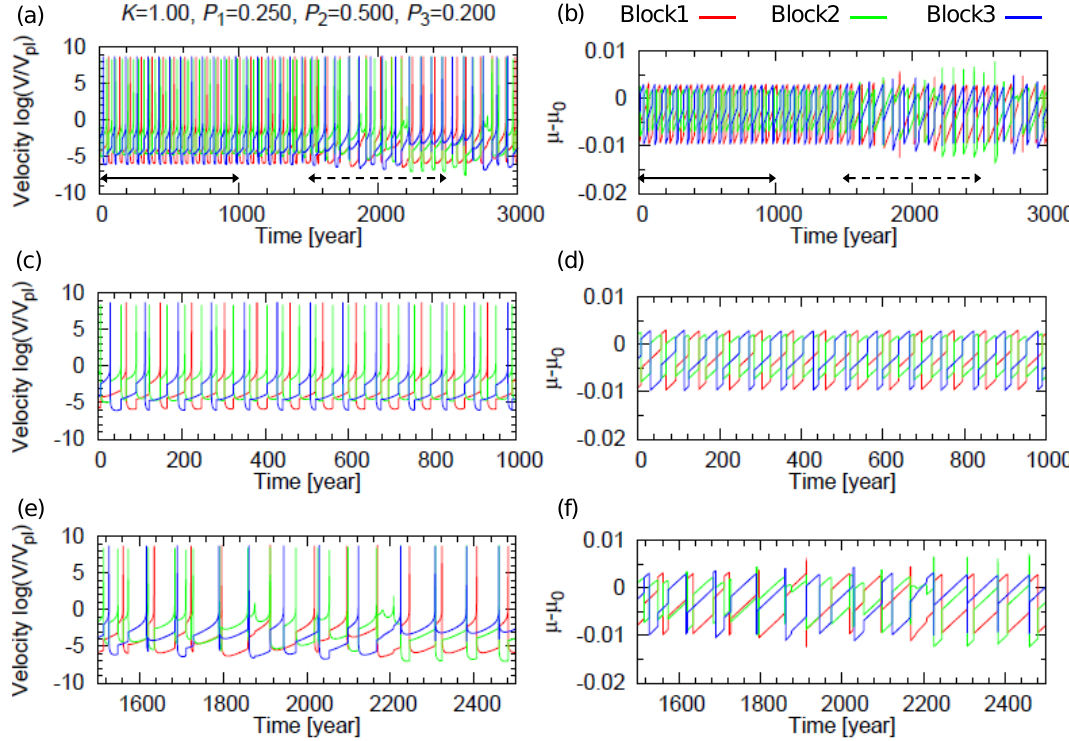
Figure 13. Example histories of (a) V and (b) µ − µ ∗ for pattern 5. The model parameters are set to K = 1 . 00, P 1 = 0 . 250, P 2 = 0 . 500, and P 3 = 0 . 200. The sections indicated by the solid arrows in (a) and (b) are expanded in (c) and (d) , and those indicated by the dashed arrows are expanded in (e) and (f)